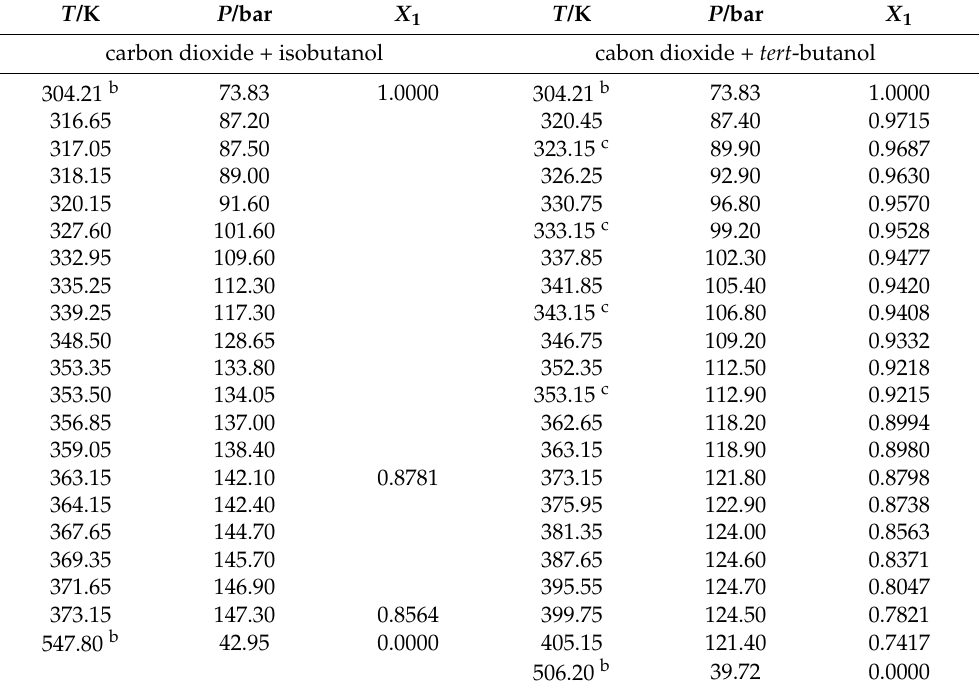
Table 5. Critical points data carbon dioxide (1) + isobutanol (2) and carbon dioxide (1) + tert -butanol (2) binary systems a